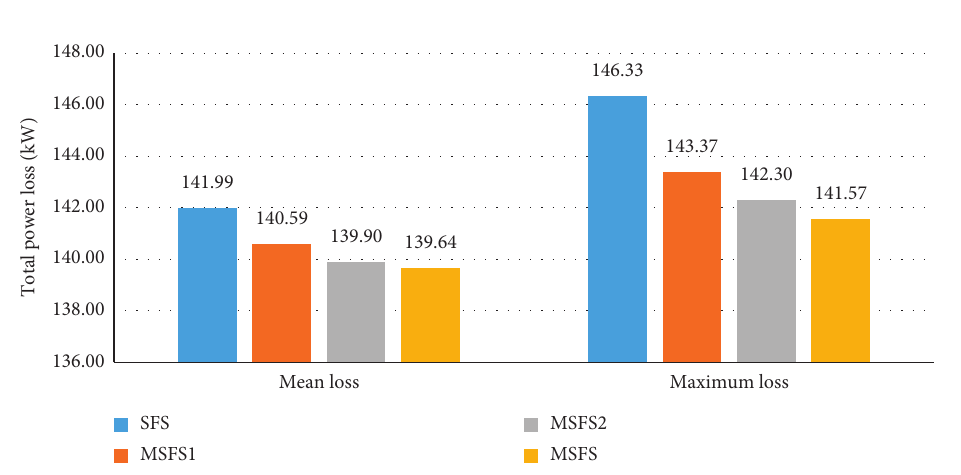
Figure 7: Mean and maximum power loss of 50 trial runs obtained by SFS methods for case 2 of the 33-bus system.